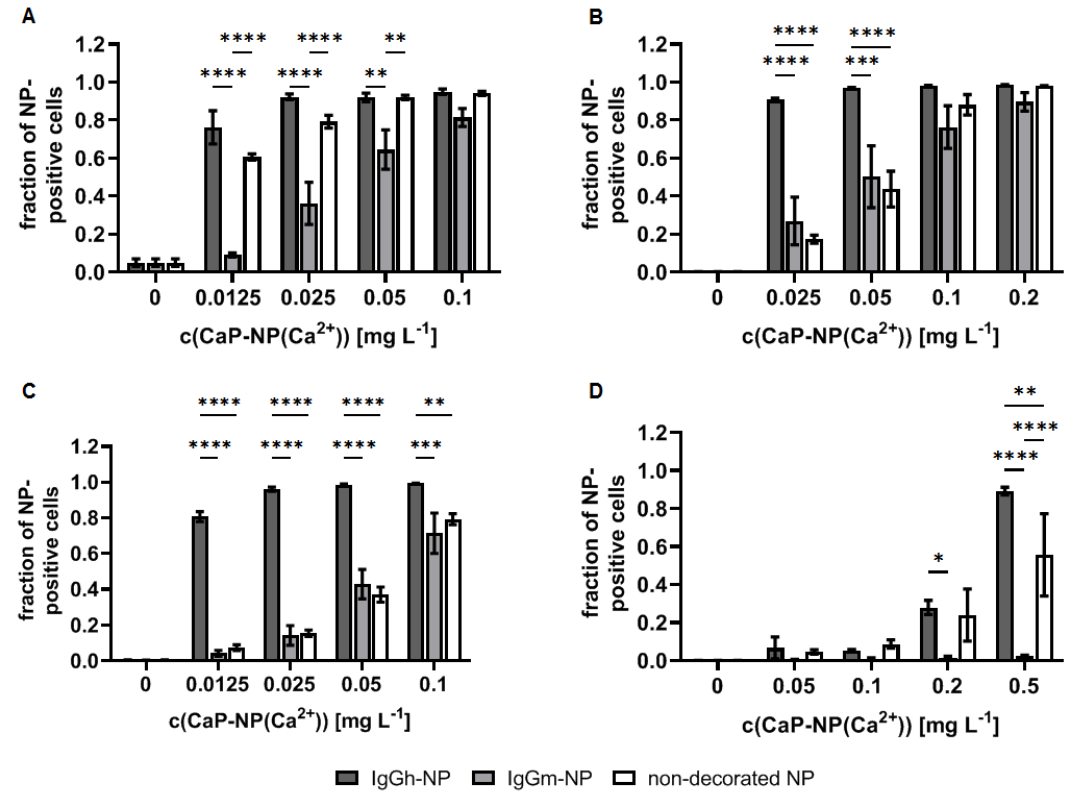
Figure 6. IgG of xenogenic origin exhibit high uptake rates compared to allogenic origin or non-decorated CaP/PEI-Cy5/SiO 2 nanoparticles in cellular players of inflammation. Uptake in murine B-cells (( A ) MOPC-315), endothelial cells (( B ) SVEC-10), monocytes (( C ) J774A.1), and T-cells (( D ) TK-1) after 24 h of incubation. Cells were analyzed by flow cytometry (fraction of Cy5-positive cells after nanoparticle accumulation). Nanoparticles were decorated with Armenian hamster (IgGh) or murine IgG (IgGm) antibodies without any target specificity to cells under investigation. For detailed specification of nanoparticle formulations used, see Tables 1 and 2. Statistical differences between indicated groups with * p < 0.05, ** p < 0.01, *** p < 0.001, **** p < 0.0001.